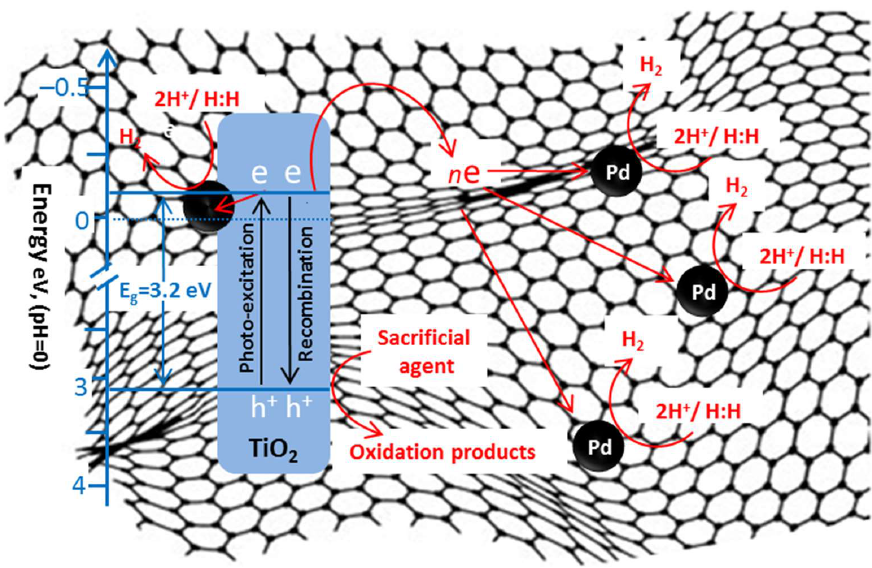
Figure 9. Photocatalytic hydrogen production over Pd 1 /rGO 4 −TNRs photocatalysts.